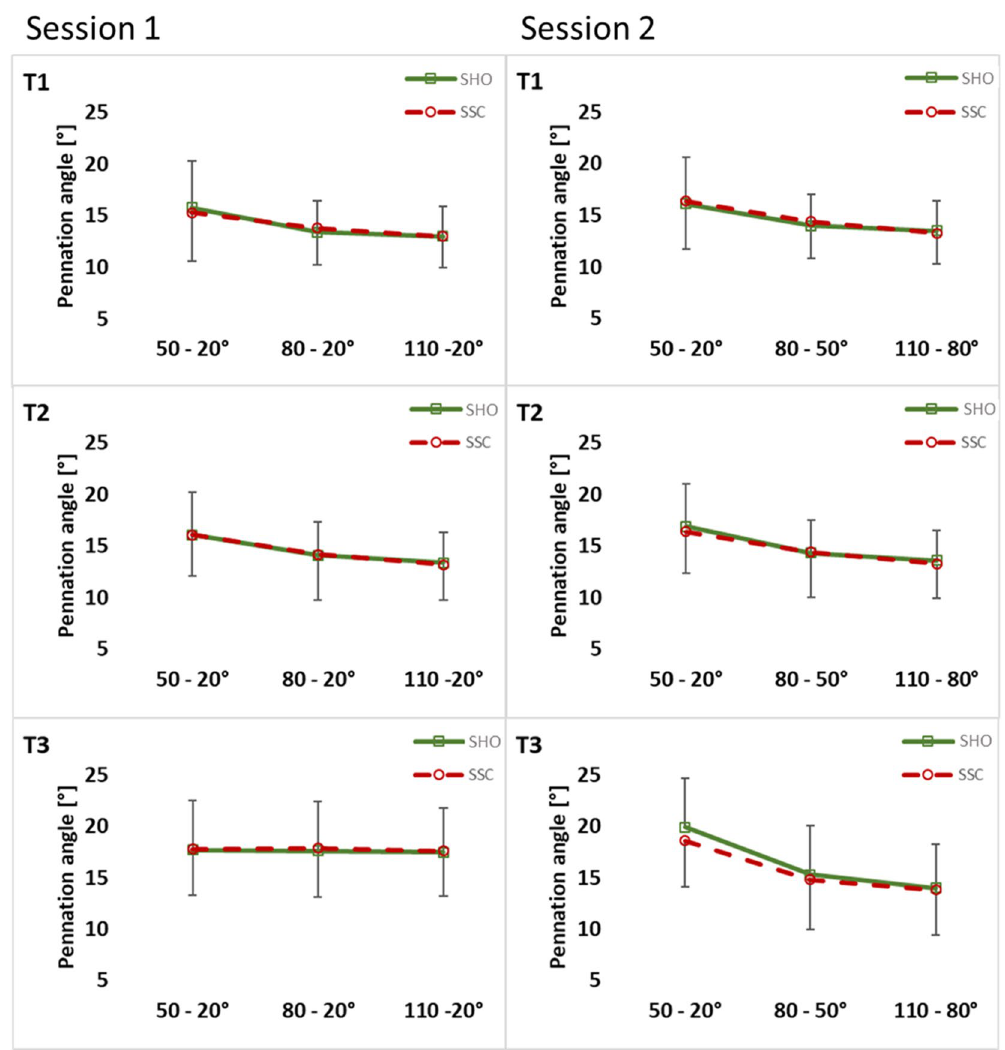
Figure 7. Mean (± SD, n = 25) values of pennation angle in both test sessions. T1 is the time point at the onset of shortening, T2 in the middle of the shortening phase, T3 the time point at steady-state after the dynamic phase. No significant interaction (condition × magnitude) and (condition × muscle–tendon unit length) was found at all instances